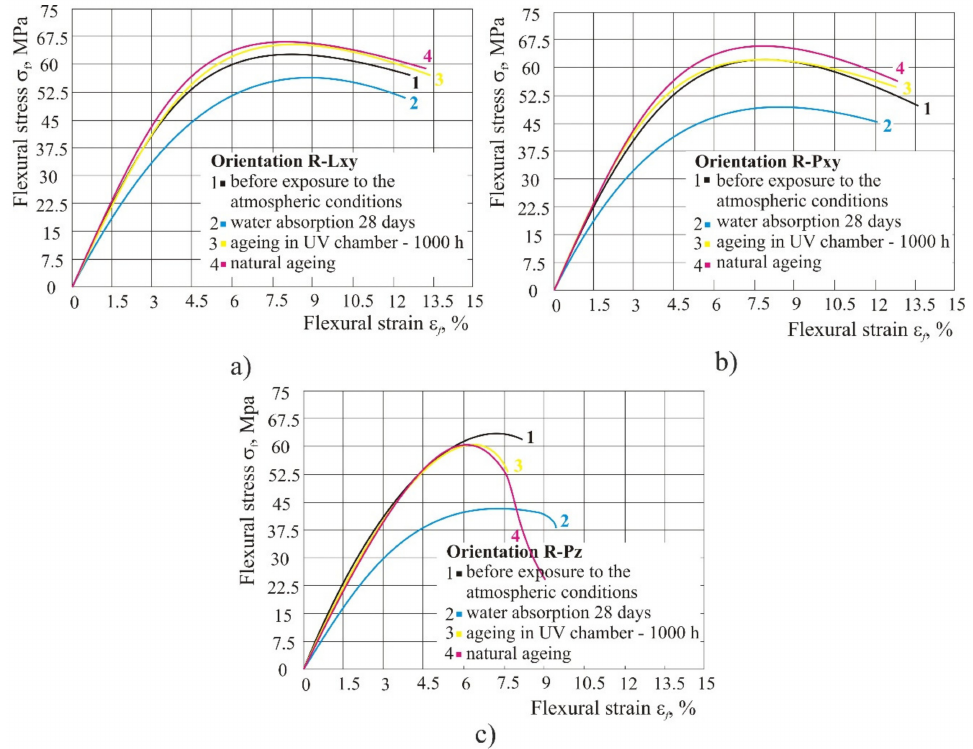
Figure 14. Impact of different atmospheric conditions on recycled material: ( a ) orientation Lxy, ( b ) orientation Pxy, ( c ) orientation Pz.